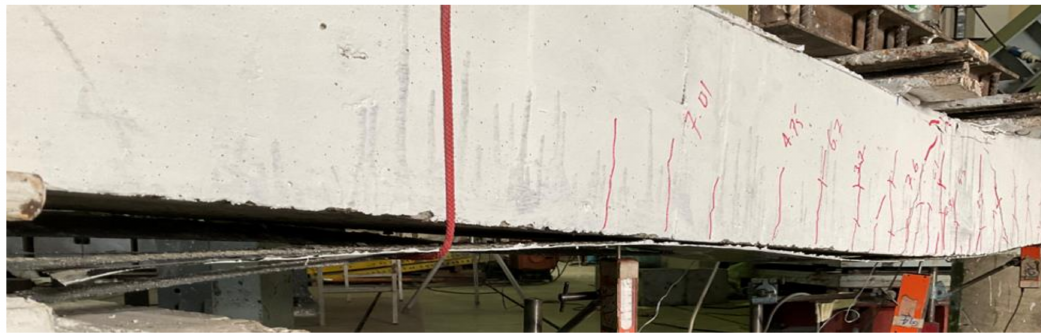
Figure 12. Failure mode of beam B04-SS-SCA.